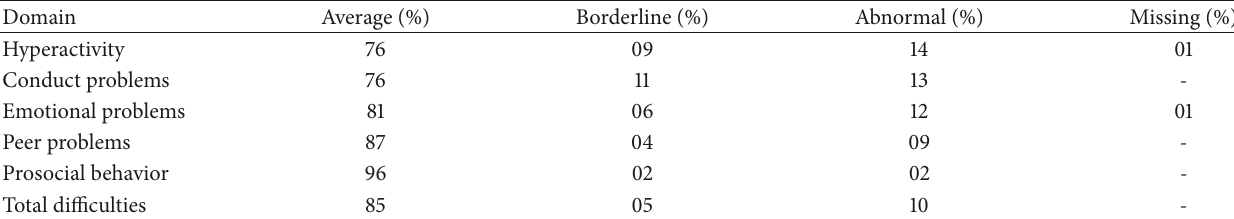
Table 2: Proportion of psychological problems in